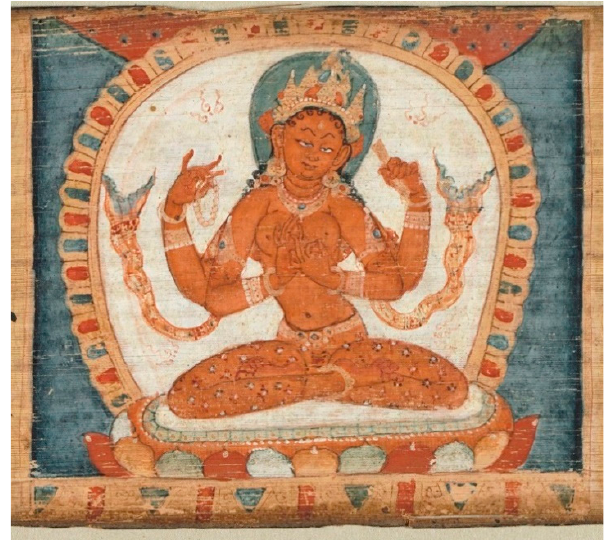
Figure 8. Prajñ ā p ā ramit ā , detail of fol. 90r. Perfection of Wisdom in Eight Thousand Lines: A ṣṭ as ā hasrik ā Prajñ ā p ā ramit ā -s ū tra , 1119. Nepal. Gum tempera and ink on palm leaf. 6.1 × 6.4 cm. Cleveland Museum of Art, purchase from the J. H. Wade Fund, 1938.301.3.